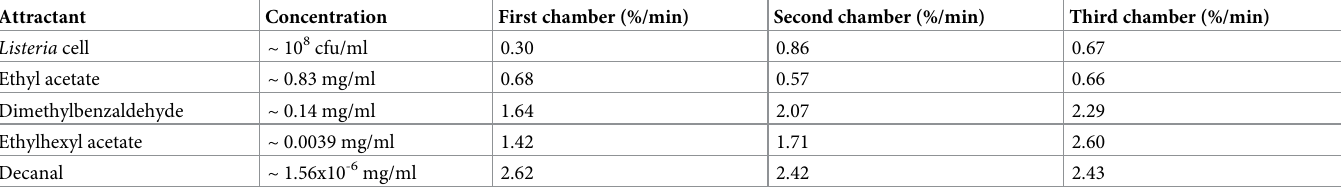
Table 2. Rate of change for Euglena with each